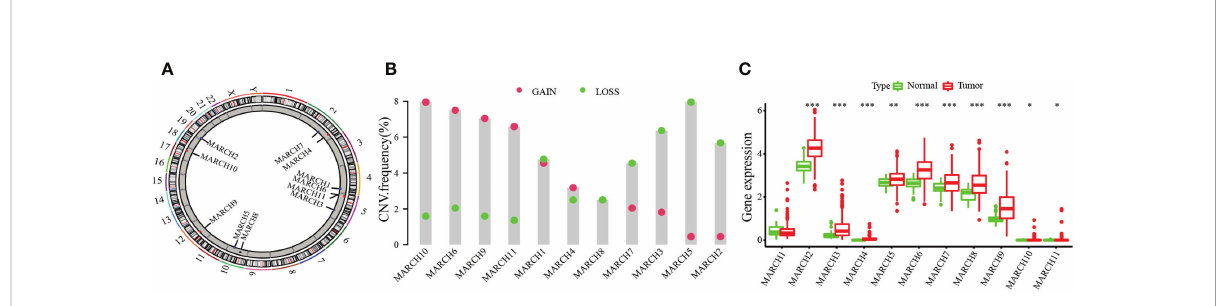
FIGURE 1 The genetic alterations of the membrane ‐ associated RING ‐ CH (MARCH) ligase landscape in hepatocellular carcinoma (HCC). (A) The CNV alteration location of MARCH ligase on chromosomes. (B) The CNV mutation frequency of 11 MARCH ligases was prevalent. The column represents the alteration frequency. The deletion frequency, blue dot; the ampli fi cation frequency, pink dot. (C) Differences in the gene expression levels of 11 MARCH ligases between normal and tumor samples. The asterisks represent statistical p -value (* p < 0.05; ** p < 0.01; *** p <